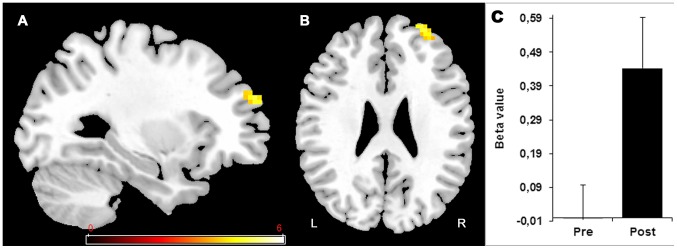
DIVIDED VARIABLE training effect.Increased (Post>Pre) activation in dual-task with more emphasis on detection (20% Equation (20/80)) is found in the right superior and middle frontal gyrus (10). Histogram in (C) indicates the Beta value (activity estimates ± SE) in the region showing increase activity in right superior and middle frontal gyrus during pre and post training session. The threshold for display is P<0.001, uncorrected, 10 voxels. Coloured bar is representative of t scores mentioned in Table 5. “L” denotes the left side of the brain, while “R” denotes the right side.